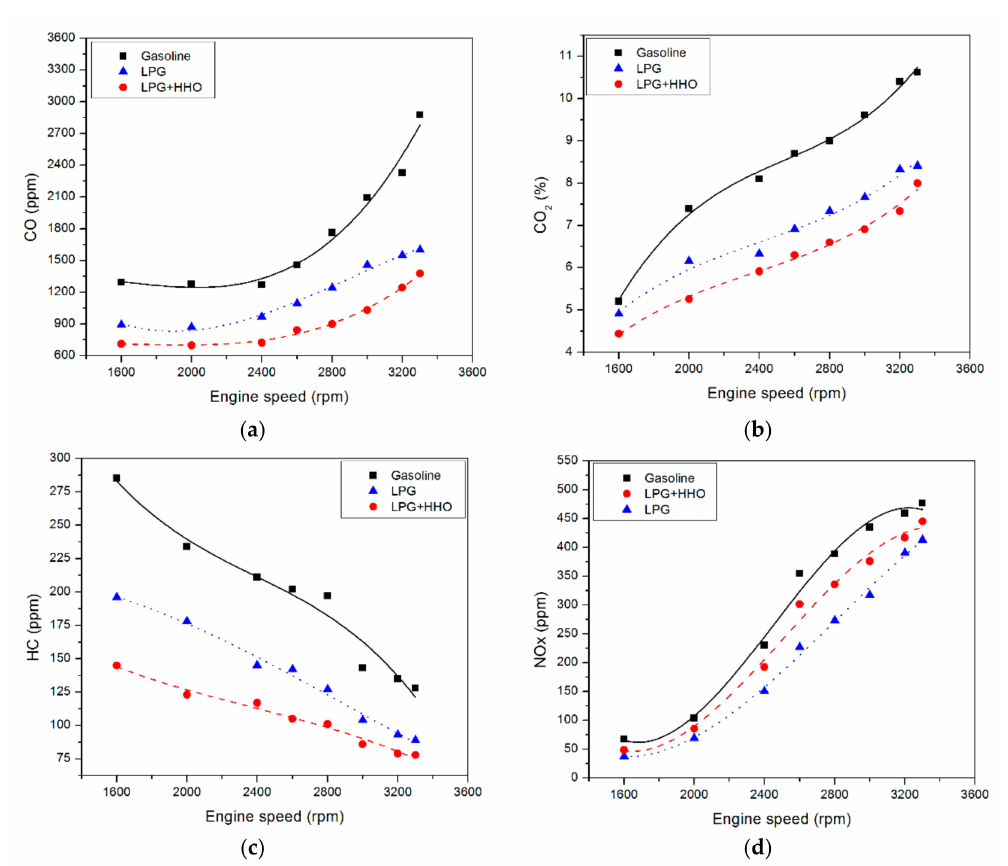
Figure 9. ( a – d ) Comparison of CO, CO 2 , HC and NO x for gasoline, LPG and